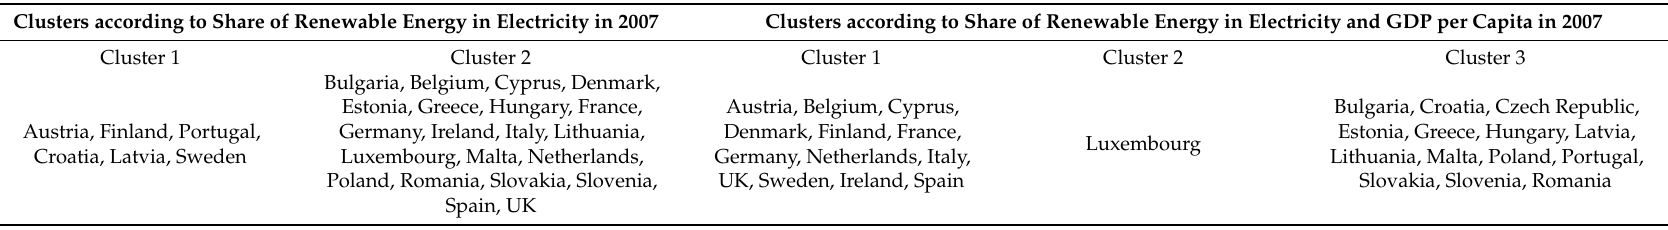
Table 3. Countries clusters according to the share of RES in the final consumption in the EU-28 in 2007 (k-means method). Clusters according to Share of Renewable Energy in Electricity in 2007 Clusters according to Share of Renewable Energy in Electricity and GDP per Capita in 2007